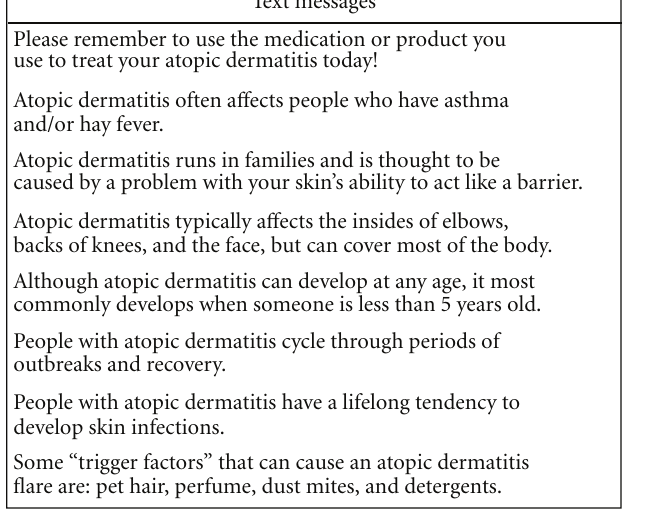
Figure 1: Examples of text messages sent to subjects.